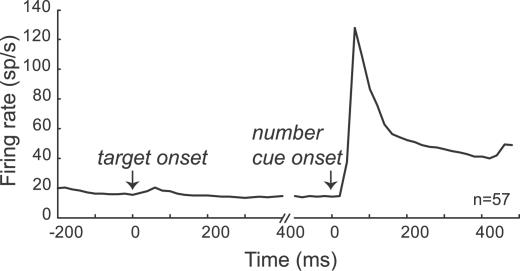
LIP Neurons Respond to the Onset of the Numerical Cue, Located within the RF, But Not to the Saccade Target, Located in the Opposite HemifieldFor all 57 neurons studied, average firing rate was calculated in 20-ms bins. Trials are first aligned to the time that the saccade target appears (indicated by arrow). The break in the abscissa acknowledges the variable length of the delay before number cue onset. Following the appearance of the numerical cue in the RF (arrow), there is a large increase in LIP activity.